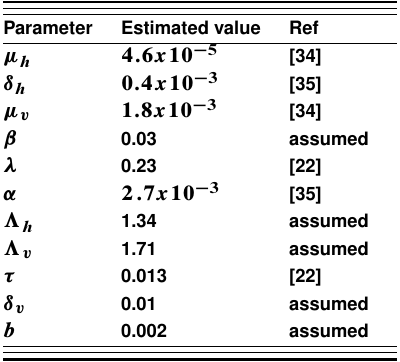
Table 3. Description of Variables and Parameters of the Leptospirosis Model (1). The units of (cid:22) h ;(cid:22) v ;˛;ƒ h ;ƒ v ;(cid:28);ı h ı v are day (cid:0) 1 , the other parameters are without units.